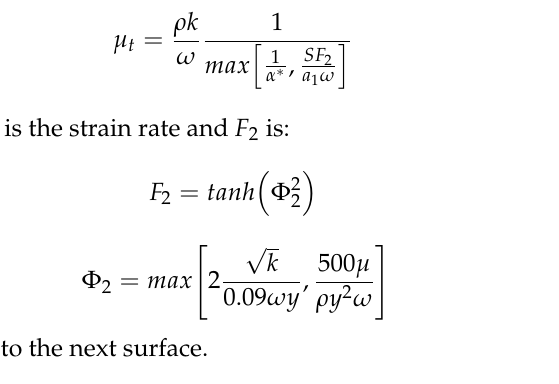
Figure 7. Analysis of mesh independence.